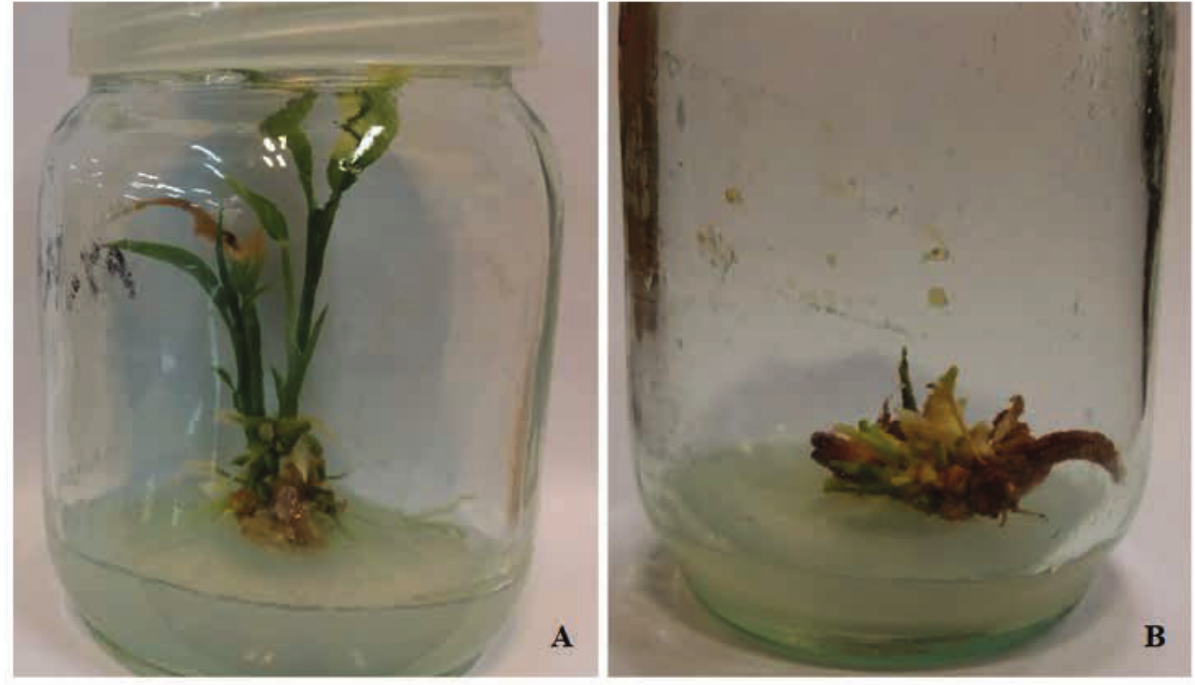
Table 3: Effect of auxins on in vitro rooting of ginger. Auxin (mg/l)